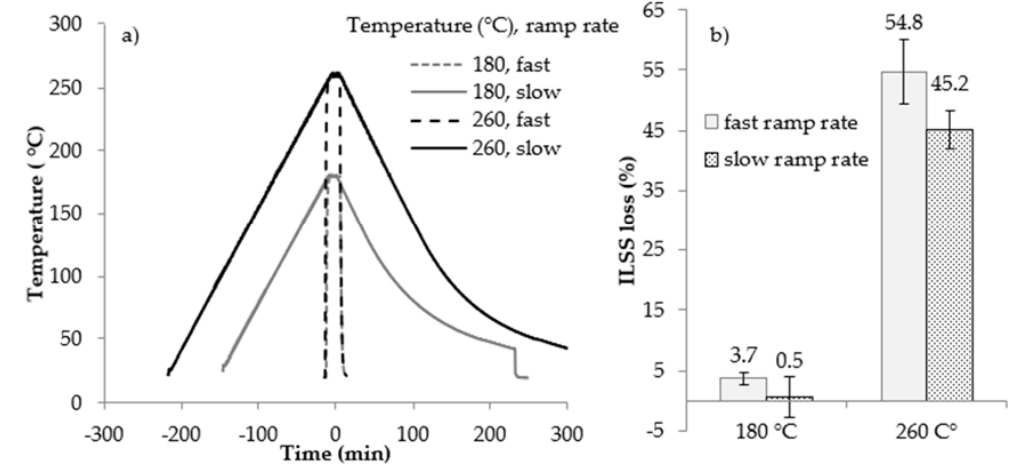
Figure A9. ( a ) Thermal exposure profile for exposures of 180 and 260 °C using fast and slow heating rates; ( b ) loss in ILSS, as percent of original, for 180 °C and 260 °C thermal exposures at fast and slow heating rates.